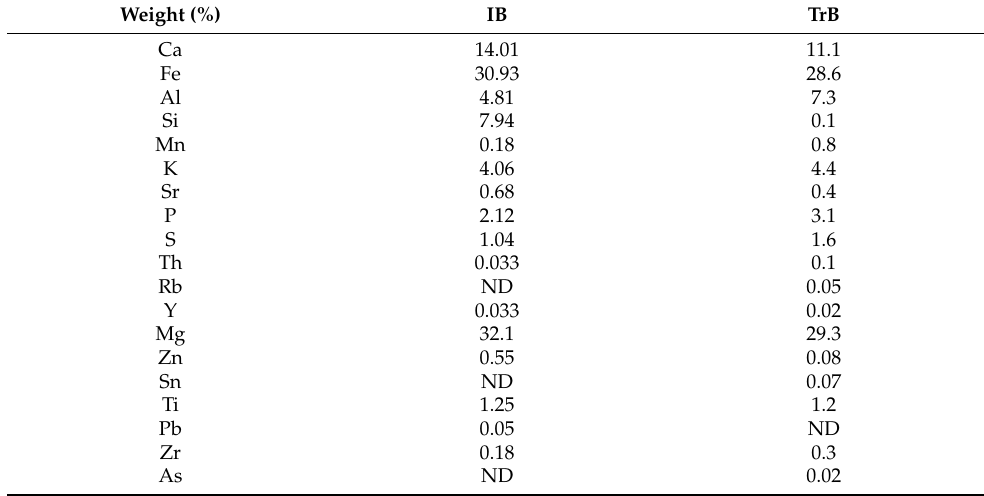
Table 2. Chemical composition of bentonite.